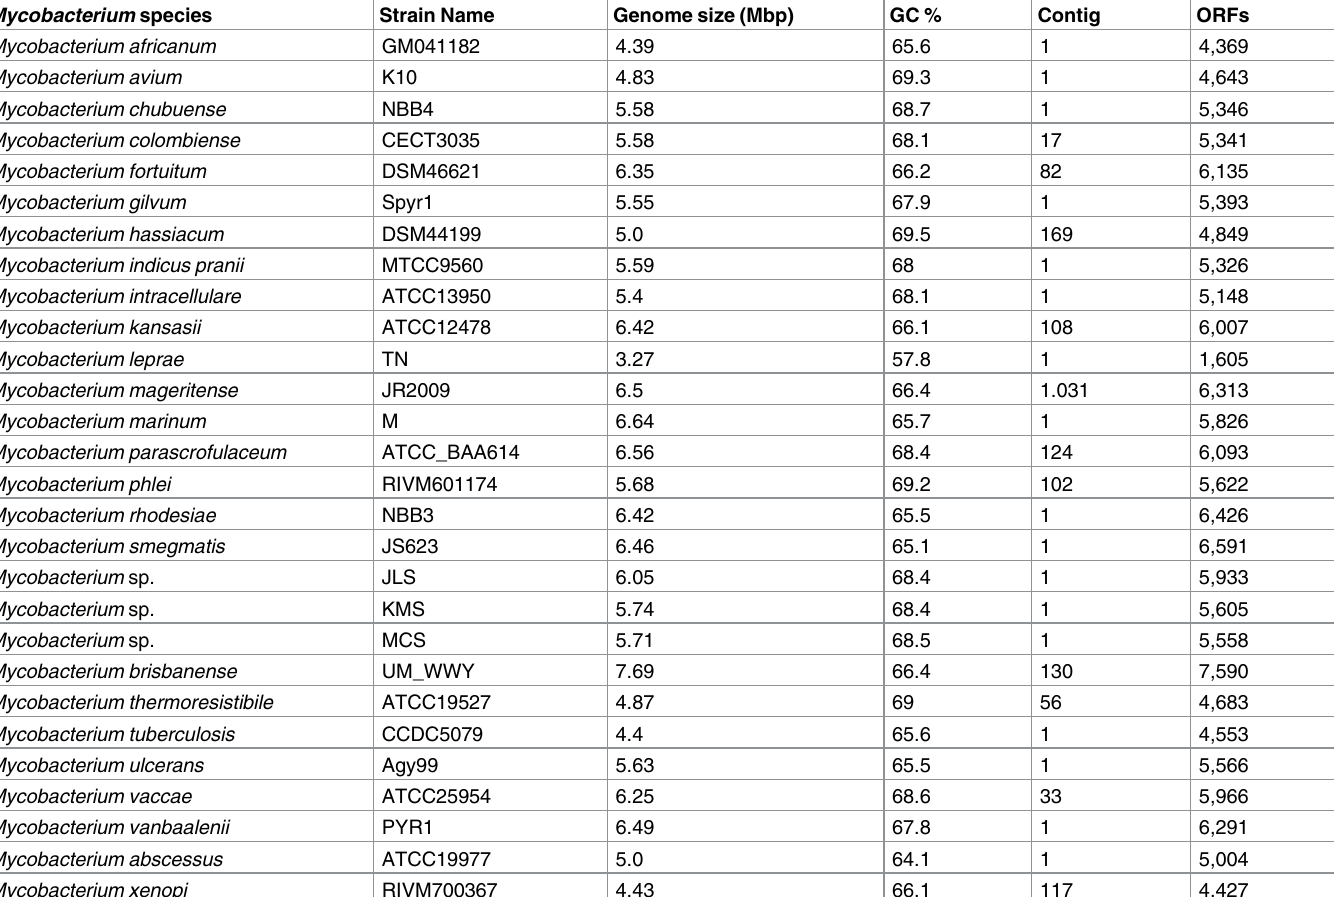
Table 1. Details of 28 different Mycobacterium species used in the